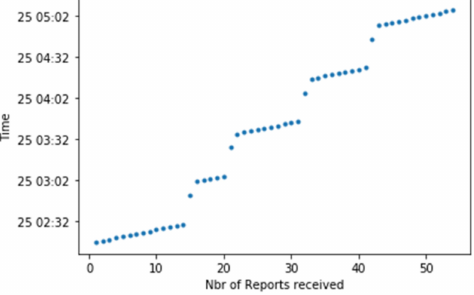
Figure 14. Number of files actually received as a function of time–1 smart